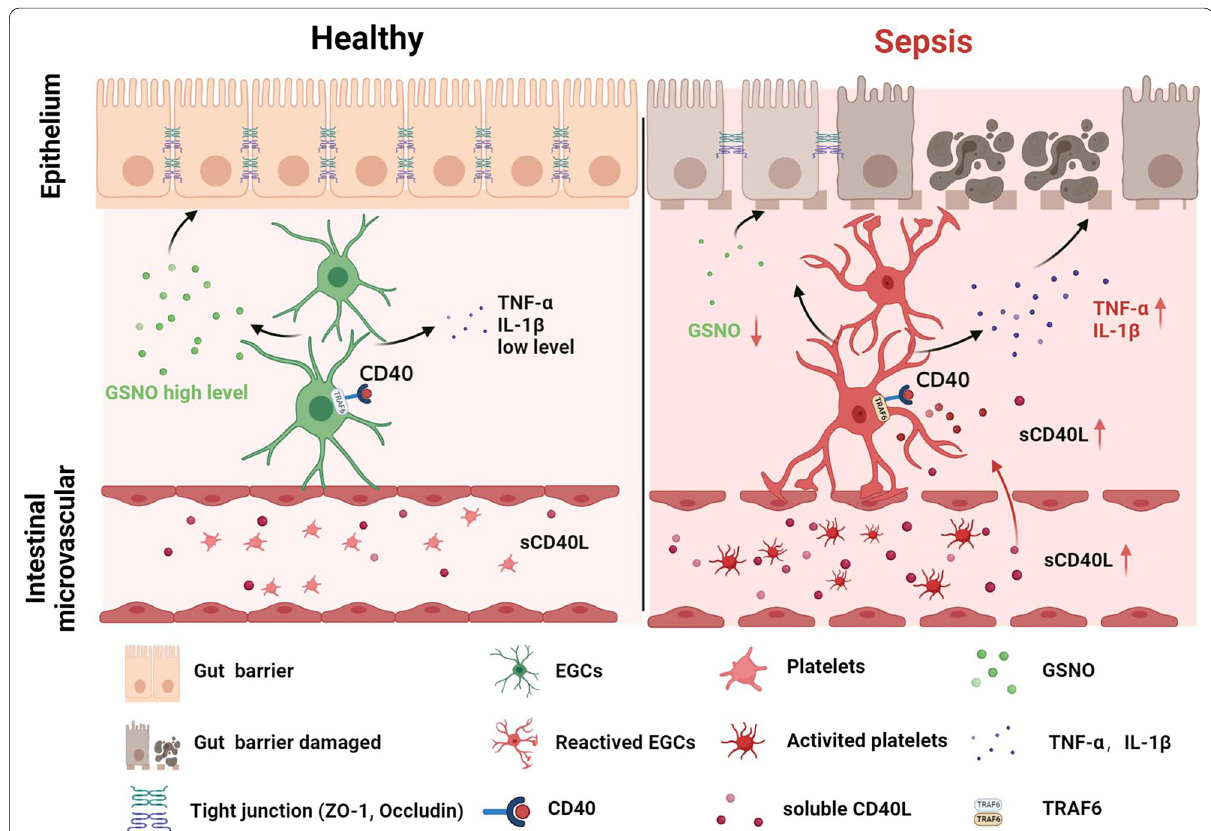
Fig. 7 Graphic summary illustration. Inhibition of platelet activation suppress reactive enteric glia and mitigated intestinal barrier dysfunction during sepsis, which is associated with CD40L–CD40 signaling